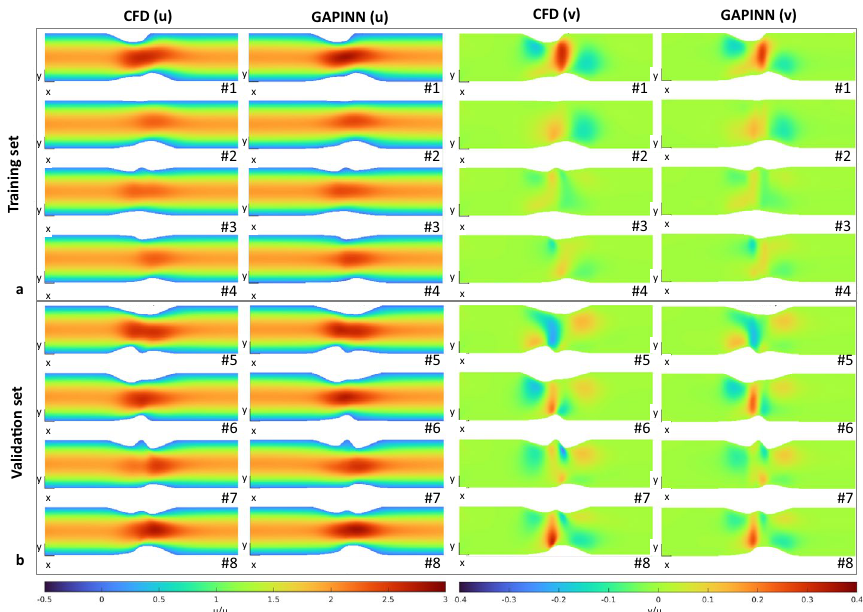
Fig. 4 Comparison between GAPINN predictions and CFD solutions eight randomly picked samples (#1–#8) of irregular vessels from training ( a ) and validation ( b ) with velocity in streamwise component u on the left and spanwise velocity component v on the